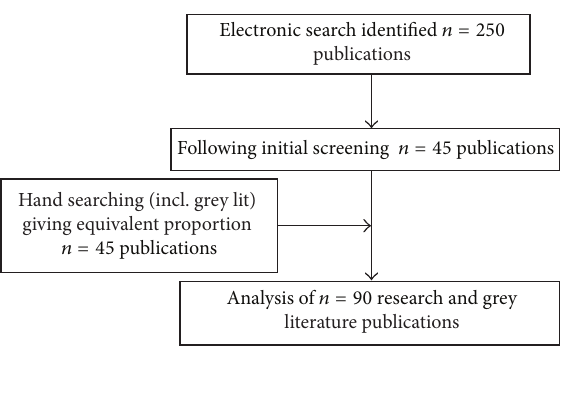
Figure 3: Search